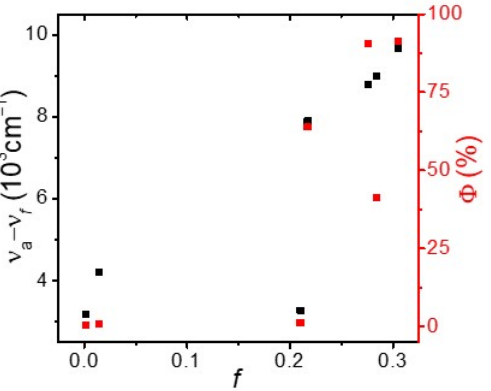
Figure 2. Stokes shifts (black point) and PLQYs (red point) of BP-3-Cz in different